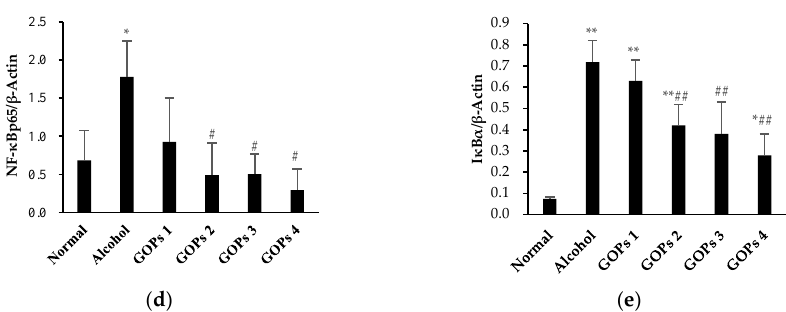
Figure 4. Effect of GOPs on the protein expression of TLR4, CD14, NF- κ B p65, and I κ B α in the liver of rats from each group. Values of all proteins were normalized to those of β -actin as the control. ( a ), β -actin; ( b ), toll-like receptor 4 (TLR4); ( c ), CD14; ( d ), nuclear factor- κ B p65 (NF- κ B p65); and, ( e ), inhibitor kappa B α (I κ B α ). Values are expressed as mean ± standard deviation of at least three independent experiments. * p < 0.05 versus control group, ** p < 0.01 versus control group; # p < 0.05 versus alcohol group, ## p < 0.01 versus alcohol group. GOPs, small molecule oligopeptides isolated from ginseng; GOPs 1 to 4 refer to administration of GOPs at a dose of 0.0625, 0.1250, 0.2500, 0.5000 g/kg, respectively.